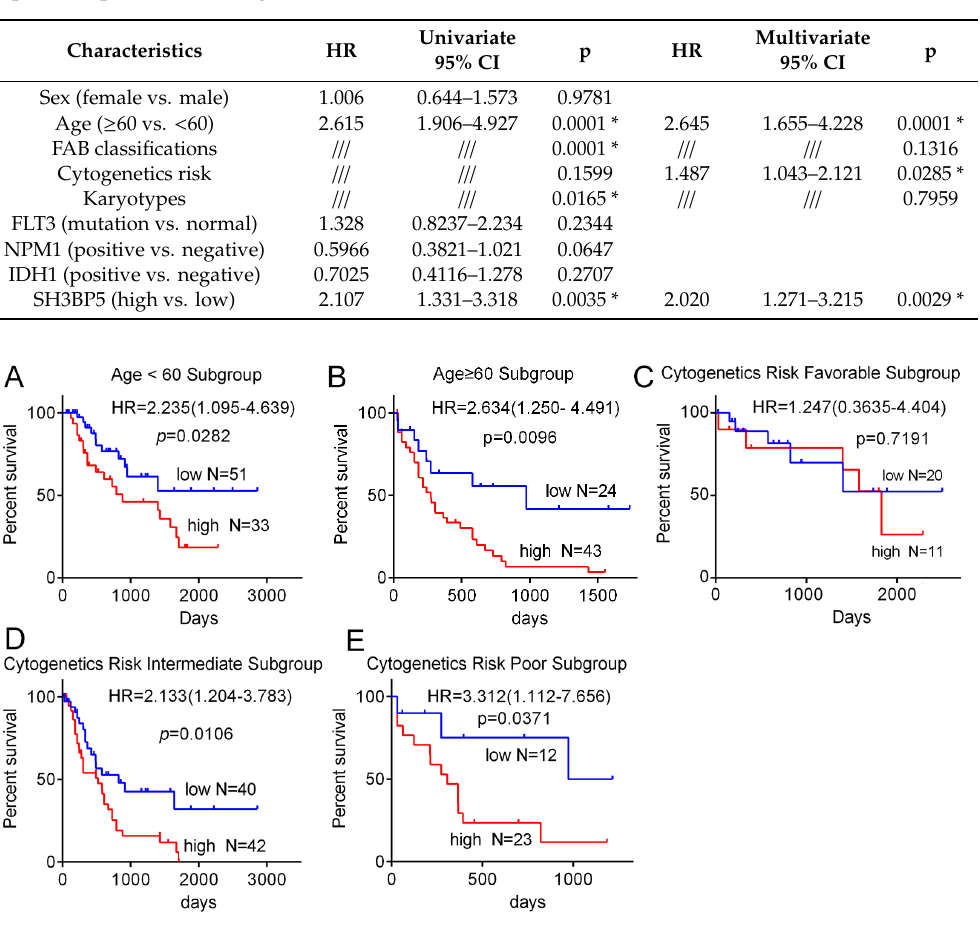
Figure 3. Relationship between SH3BP5 expression and age or cytogenetics risk in AML patients. Kaplan–Meier analysis of overall survival in patients with age < 60 ( A ) or age ≥ 60 ( B ) subgroup patients according to SH3BP5 expression level. Kaplan–Meier analysis of overall survival in patients with cytogenetics risk-favorable ( C ), intermediate ( D ), and poor ( E ) subgroup patients according to SH3BP5 expression level. p value was calculated by log-rank